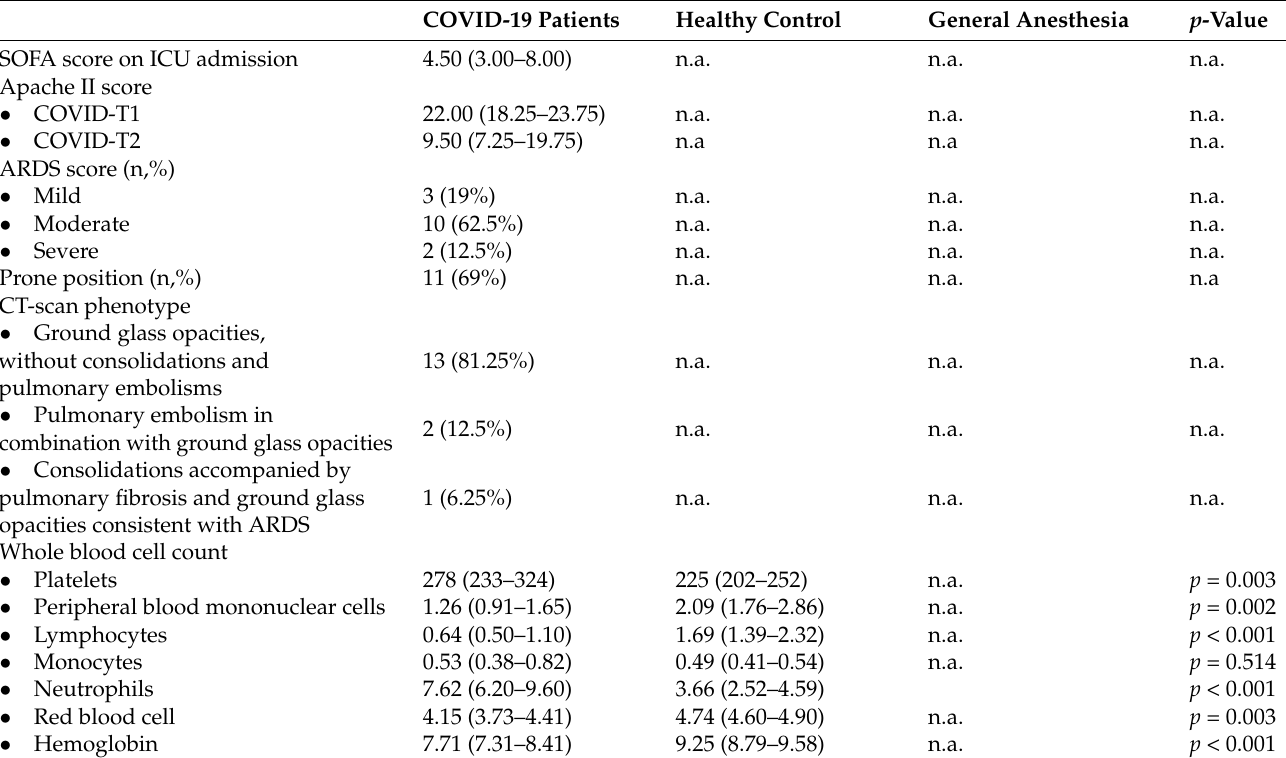
Table 1. Cont . COVID-19 Patients Healthy